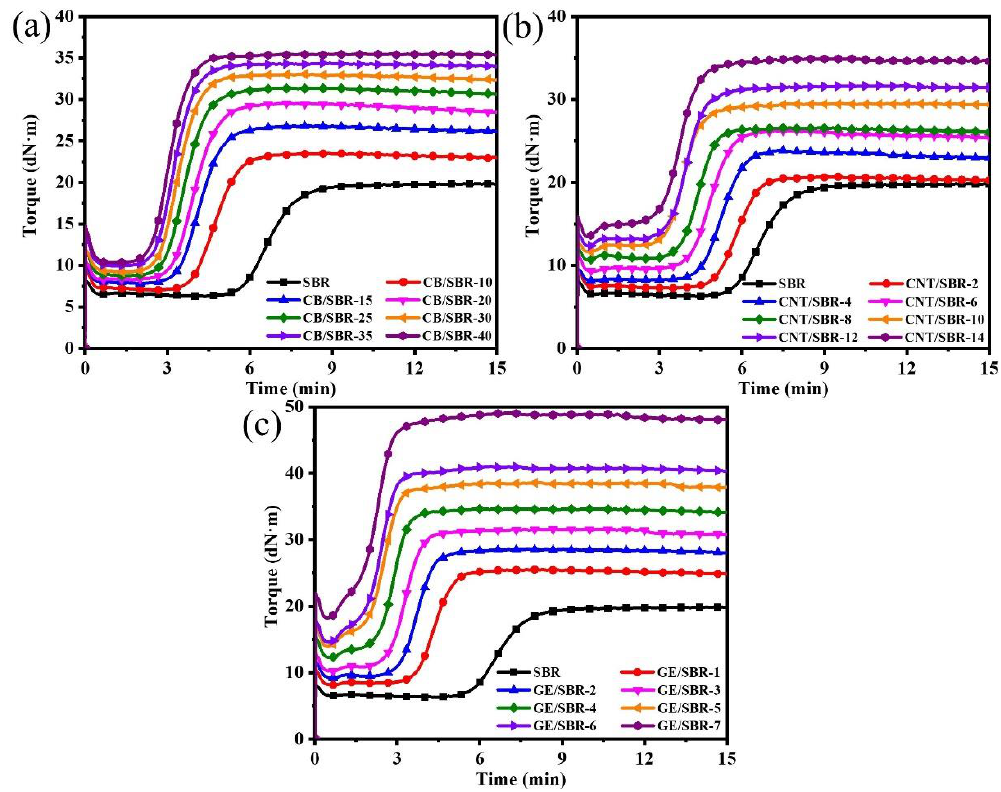
Figure 4. Curing characteristics of SBR compounds filled with different contents of ( a ) CB; ( b ) CNTs and ( c ) GE.